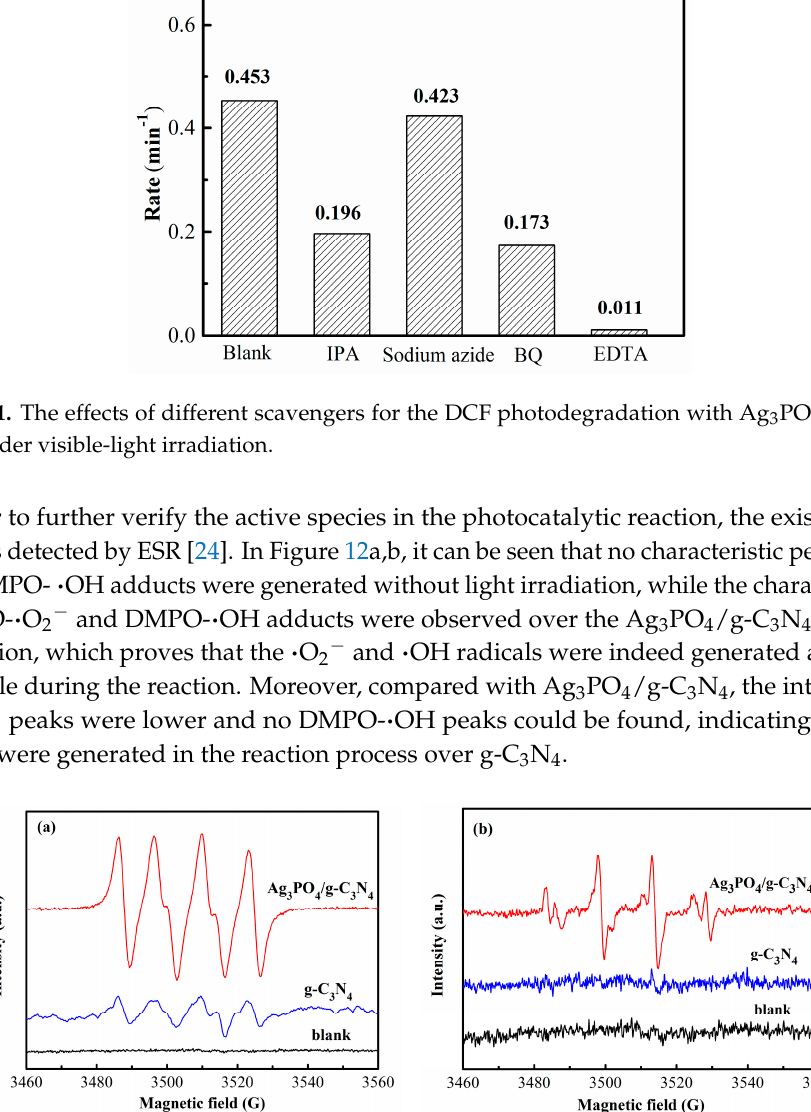
Figure 12. ESR signals of ( a ) DMPO ‐ ∙ O 2 − in methanol dispersion; and ( b ) DMPO ‐ ∙ OH in aqueous dispersion with visible ‐ light irradiation.